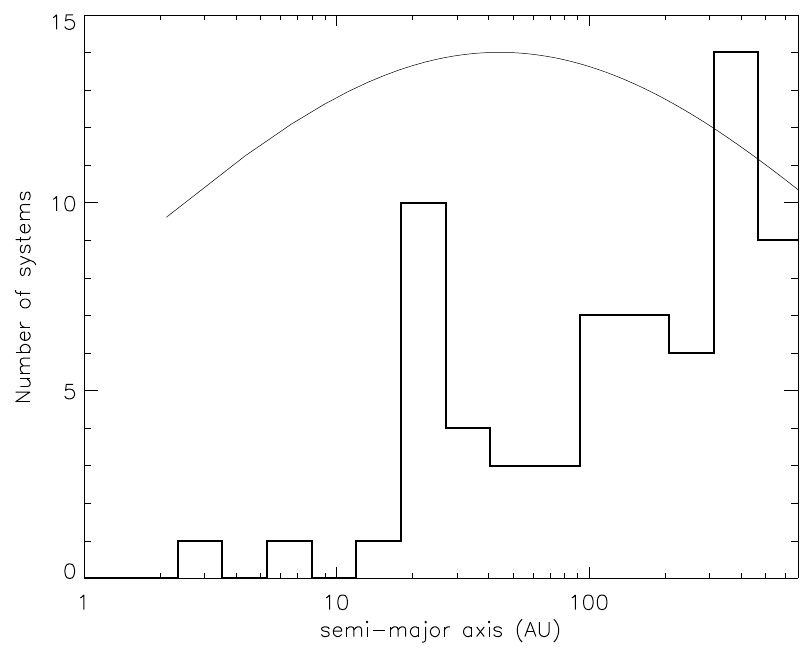
Figure 3. Distribution of the semi-major axis of all S-type exoplanet-hosting binaries with a projected separation up to 500 au. When the semi-major axis a b is not known and only the projected separation ρ is available, b a is estimated through the statistical relation log ( a b ) = log ( ρ ) + 0.13 [1,2]. The solid-line curve represents the normalized a b distribution for field stars derived by